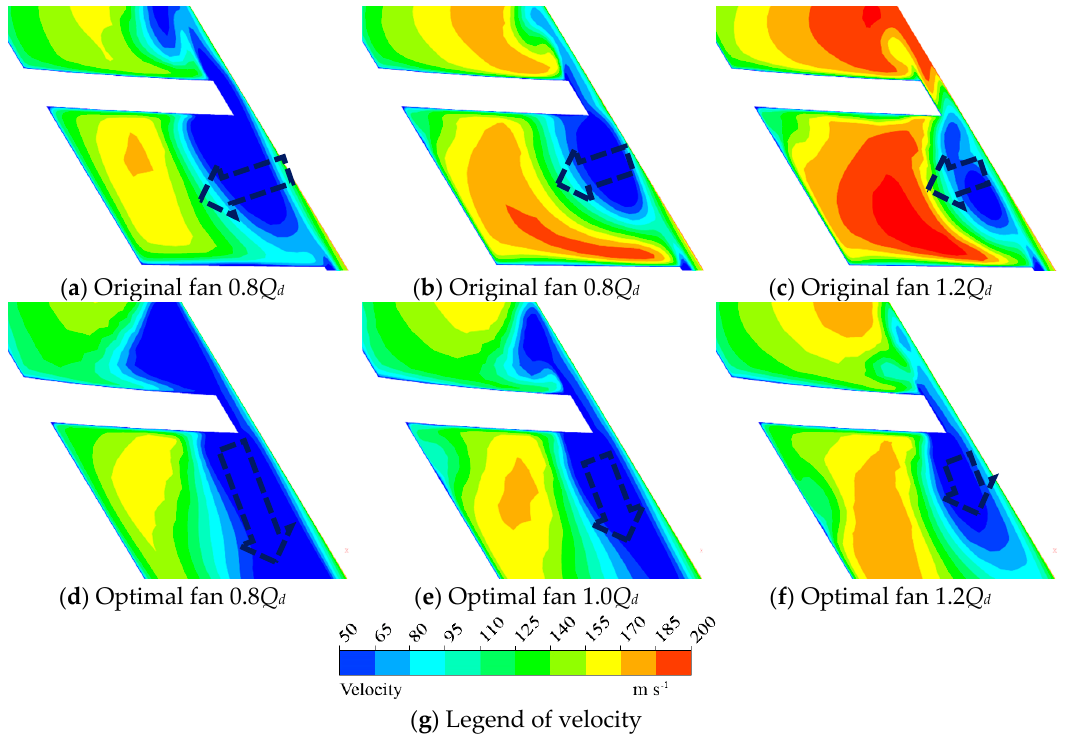
Figure 8. Velocity distribution in tip clearance. ( a ) Original fan 0.8 Q d ; ( b ) Original fan 0.8 Q d ; ( c ) Original fan 1.2 Q d ; ( d ) Optimal fan 0.8 Q d ; ( e ) Optimal fan 1.0 Q d ; ( f ) Optimal fan 1.2 Q d ; ( g ) Legend of